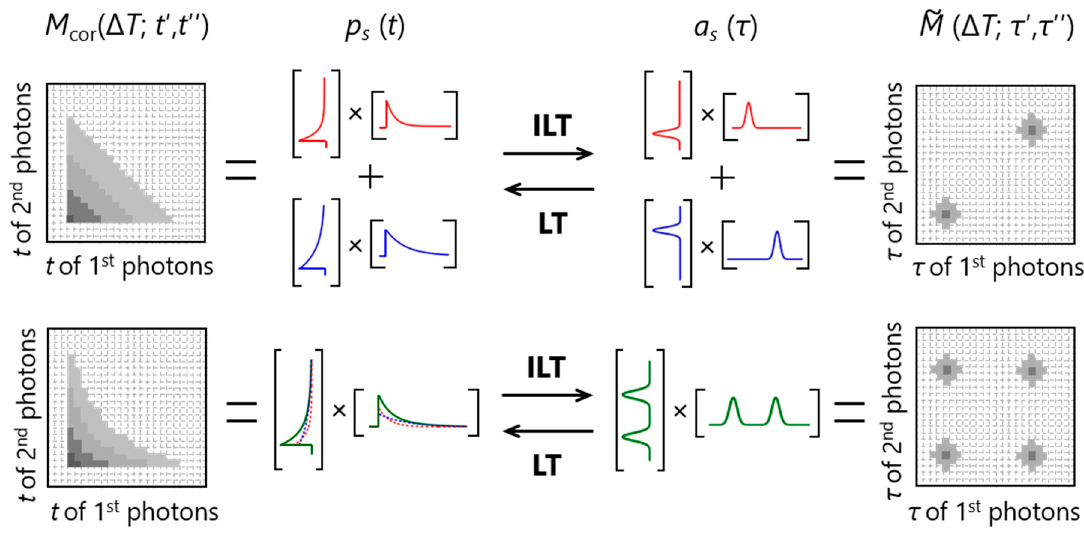
Figure 3. Relationships among a 2D emission-delay correlation map ( M cor ( ∆ T ; t (cid:48) , t (cid:48)(cid:48) )), a 2D lifetime correlation map ( (cid:101) M ( ∆ T ; τ (cid:48) , τ (cid:48)(cid:48) ) ), and the fluorescence decay curves ( p s ( t )) and lifetime distributions ( a s ( τ )) of independent species. ILT and LT denote inverse Laplace transform and Laplace transform, respectively.